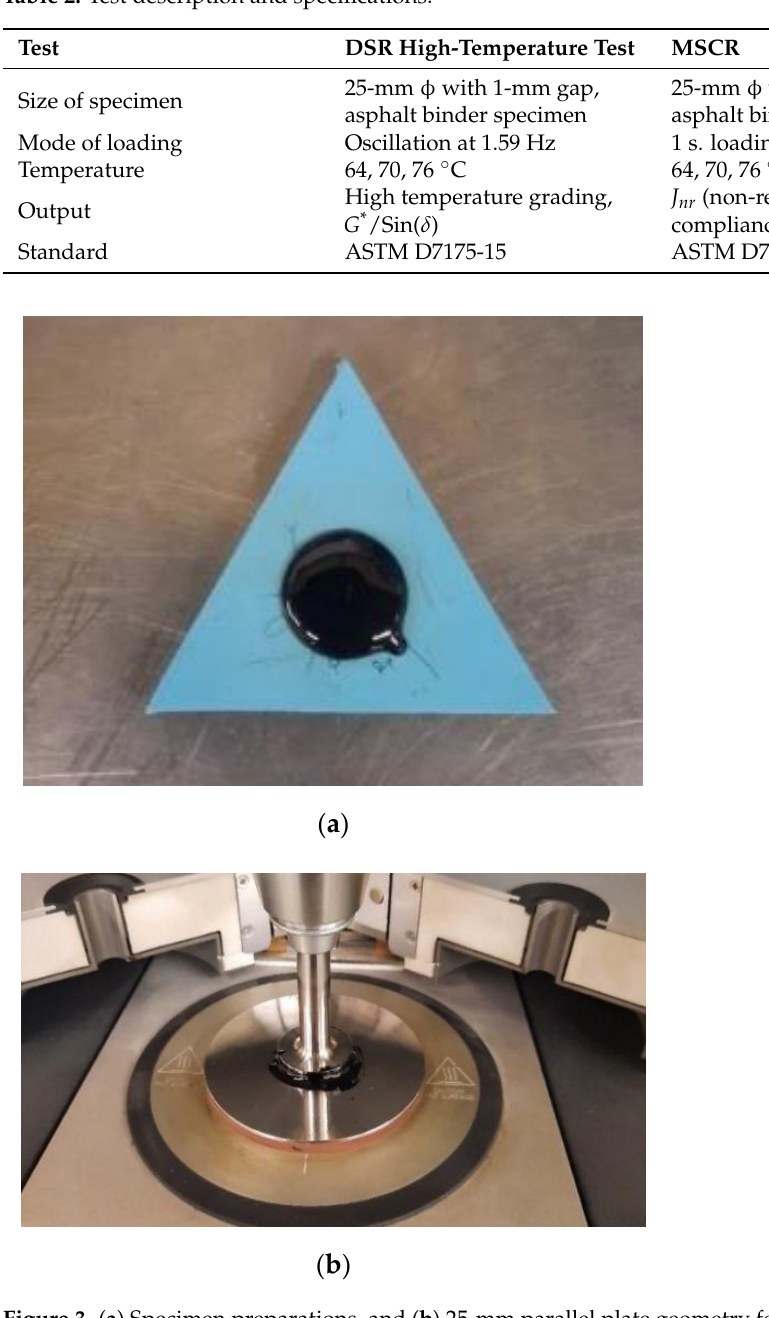
Figure 3. ( a ) Specimen preparations, and ( b ) 25-mm parallel plate geometry for the DSR and MSCR tests. Table 2. Test description and specifications.